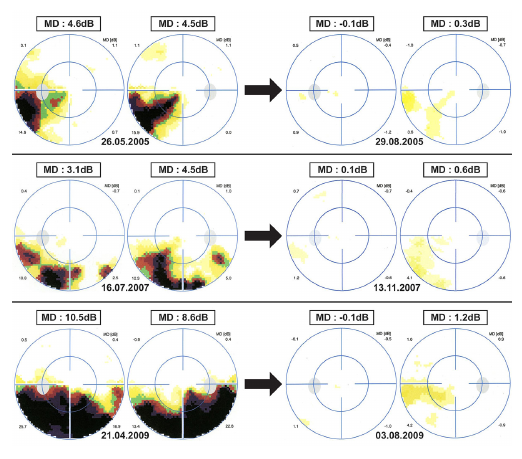
Figure 4: Recurrence of a homonymous visual field defect (HVFD), previously partially reported [22]. Top – inaugural left homonymous inferior quadrantanopsia, which disappeared com- pletely after three months. Middle – 2 years later, recurrence of the left homonymous inferior quadrantanopsia, which this time re- solved over four months. Bottom – 4 years after the initial episode, a second HVFD recurrence occurred with a bilateral inferior homonymous quadrantanopsia. Complete recovery of the HVFD was obvious after 3.5 months. MD = mean defect expressed in decibels